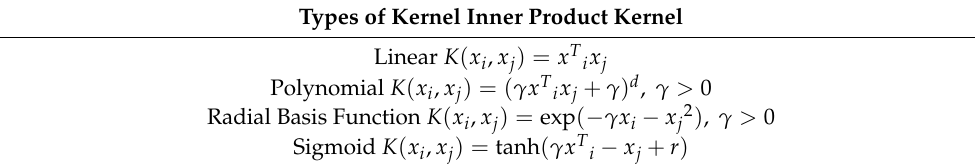
Table 1. SVM inner product kernel types. Types of Kernel Inner Product